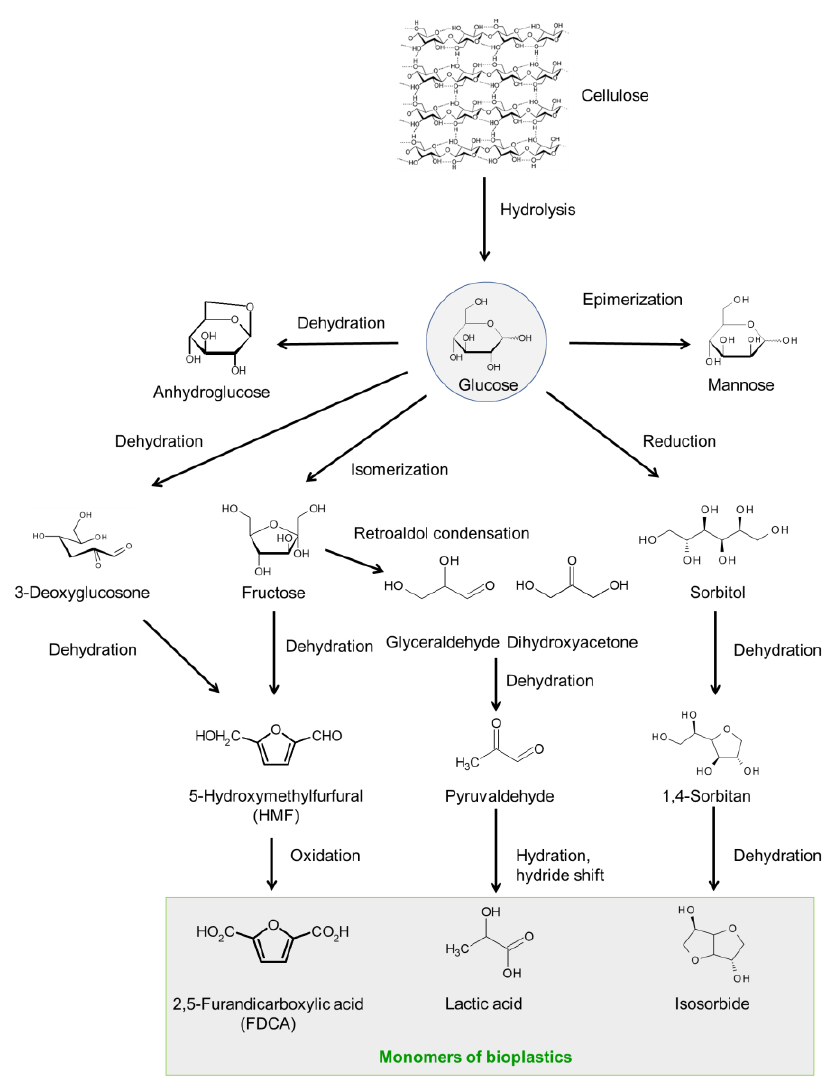
Figure 1. Reaction pathways for conversion of cellulose-based biomass toward chemicals.